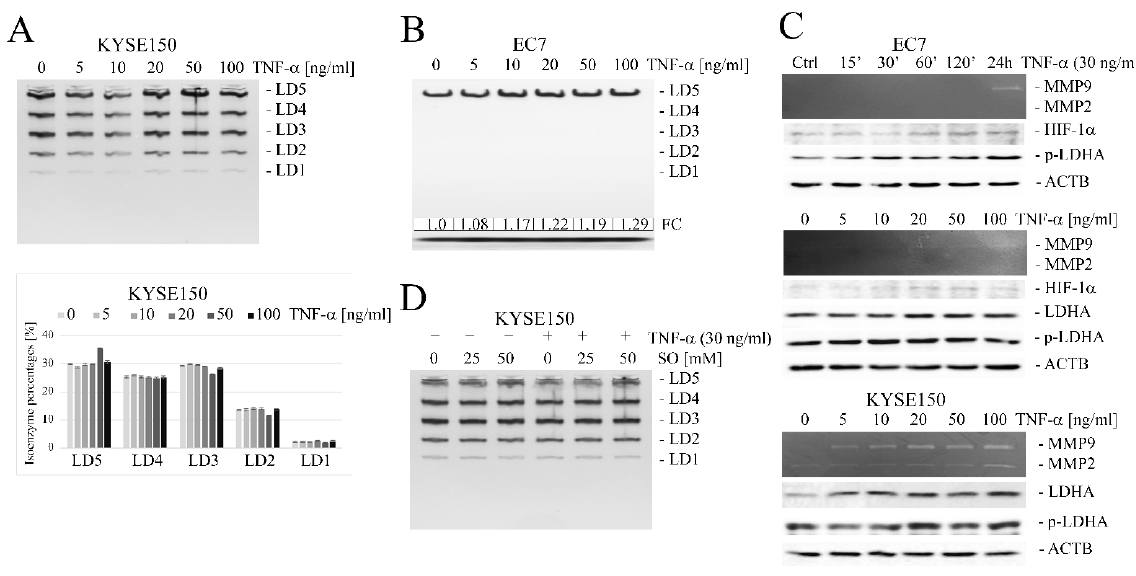
Figure 3. The effect of TNF- α on the composition of LDH isoforms and on the protein levels of LDHA and MMP9 in esophageal cancer cells. ( A ) Electrophoretic patterns in KYSE150 cells stimulated with TNF- α at different concentrations (upper panel) and the corresponding isoform profiles (lower panel) showing no change in the percentage of LDH isoforms. ( B ) Dose-dependent changes in electrophoretic patterns in EC7 cells under TNF- α stimulation; FC — fold change vs. untreated control calculated from differential densitometry of signals from the gel. ( C ) Changes in MMP9 activity by gelatin zymography and protein levels of LDHA, LDHB, HIF-1 α , phospho-LDHA(Tyr10), LDHA by Western blotting in EC7 (upper panel) and KYSE150 (lower panel), respectively, in relation to TNF- α concentration and time. ( D ) Electrophoretic pattern in TNF- α (30 ng/mL) stimulated KYSE150 for 24 h in the presence of SO (25 and 50 mM) showing no change in the relative percentage of isoenzymes. Ctrl — control, LD1-LD5 — LDH isoenzymes, ACTB — β -actin/loading control.